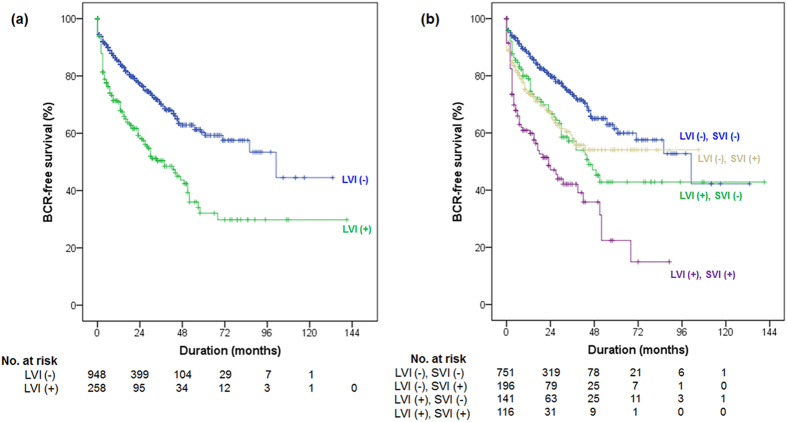
(a) BCR-free survival according to LVI in the K-CaP cohort (p < 0.001). (b) BCR-free survival according to LVI and SVI in the K-CaP cohort (p < 0.001).